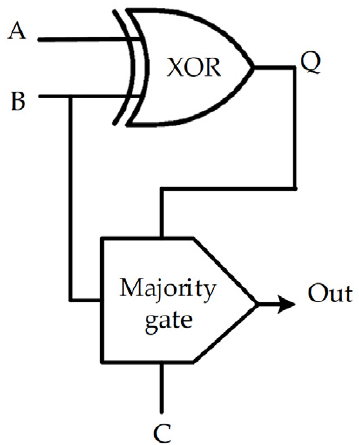
Figure 13. Schematic diagram of a 2-to-1 multiplexer